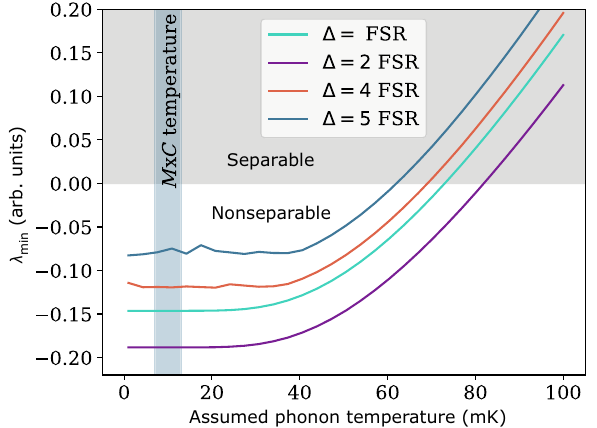
FIG. 10. PPT criterion results. We apply the PPT criterion to data presented in Fig. 3 in the main text. We vary the assumed phonon temperature, estimate G and n , and evaluate the PPT criteria at each step. The results suggest entanglement is present up to a phonon temperature of roughly 63 mK. Each line corresponds to different detunings from the pump.